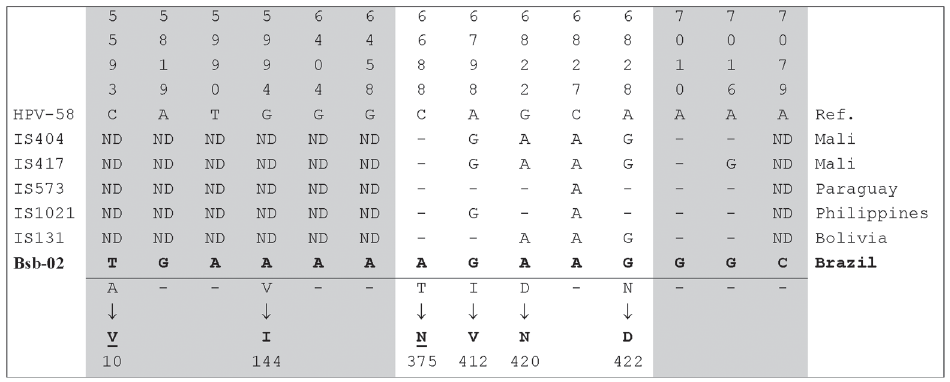
Figure 1. Nucleotide and amino acid sequence alignment showing the variations in isolate Bsb-02. Nucleotide positions of polymorphic sites are given across the top of the figure. Numbering refers to the first nucleotide of the HPV-58 reference genome (accession number NC 001443), which is indicated as Ref. Each row indicates, from left to right, the specimen identification, the nucleotide sequence alignment in comparison to the reference and the origin of each specimen. The amino acid changes and their positions are indicated below the line, in comparison to the original amino acid. Non-conservative amino acid substitutions are underlined and Bsb-02 changes that had not been described previously are highlighted in gray. ND =